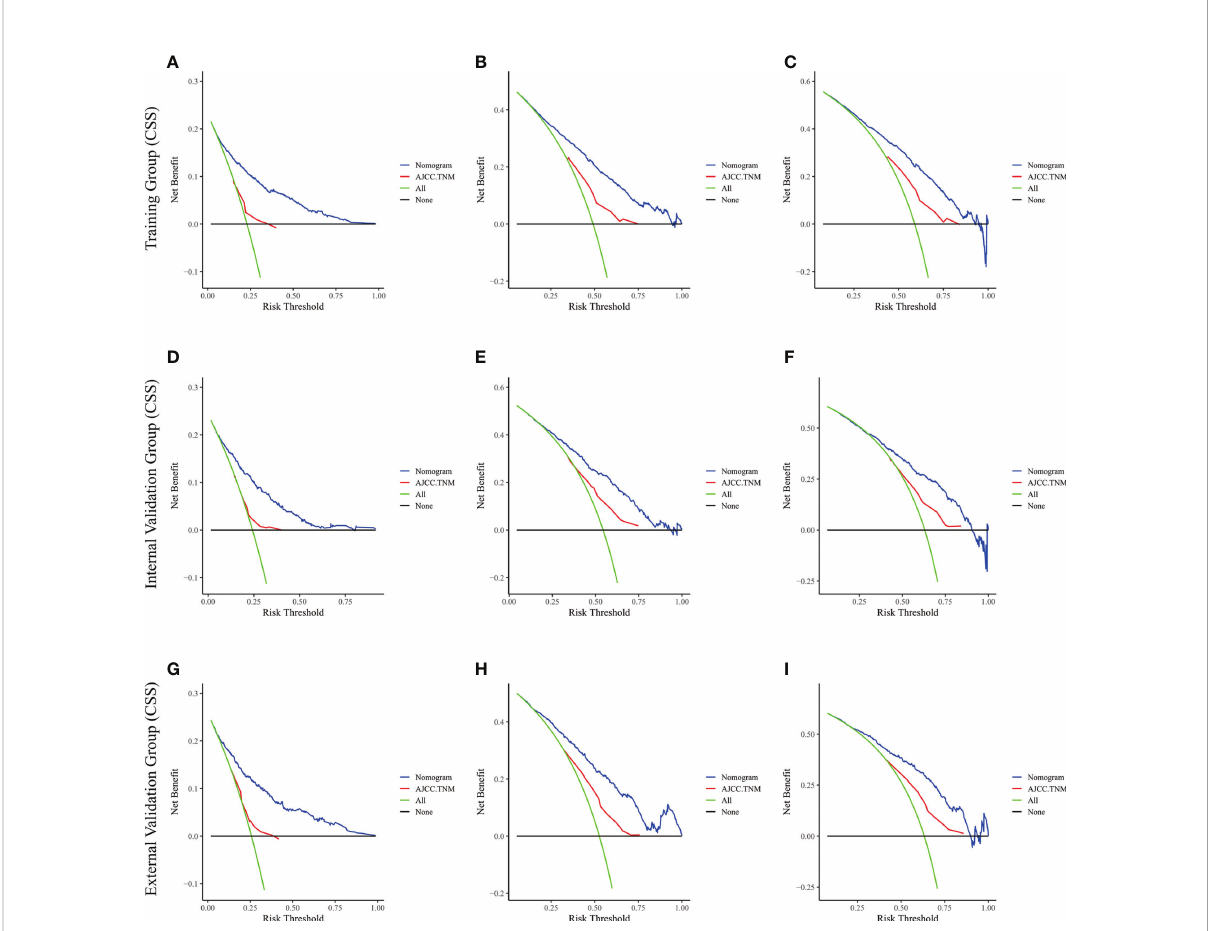
FIGURE 7 The decision curve analysis of the nomogram and AJCC.TNM for CSS at (A) 1-year and (B) 3-year and (C) 5-year in the training cohort, and at (D) 1-year (E) 3-year and (F) 5-year in the internal validation cohort, and at (G) 1-year (H) 3-year and (I) 5-year in the external validation